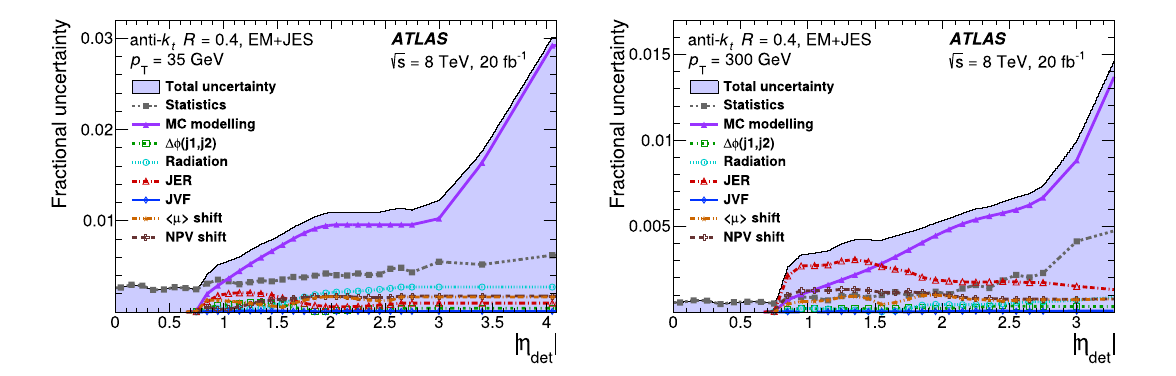
The individual components are added in quadrature to obtain the total uncertainty. The MC modelling uncertainty is the dominant component for jets with | η det | > 1 .